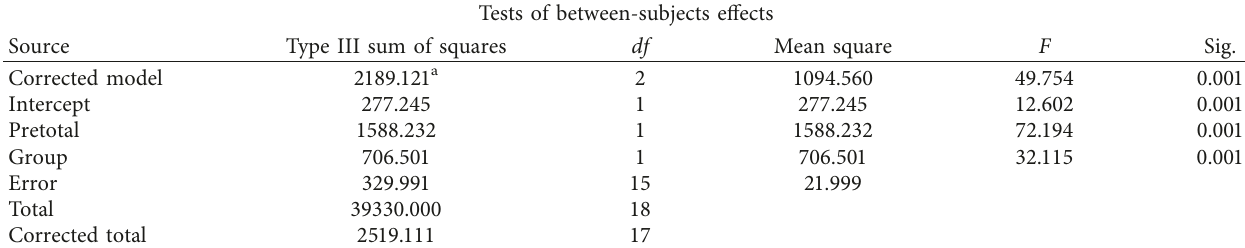
Table 3: ANCOVA of low-achiever students.